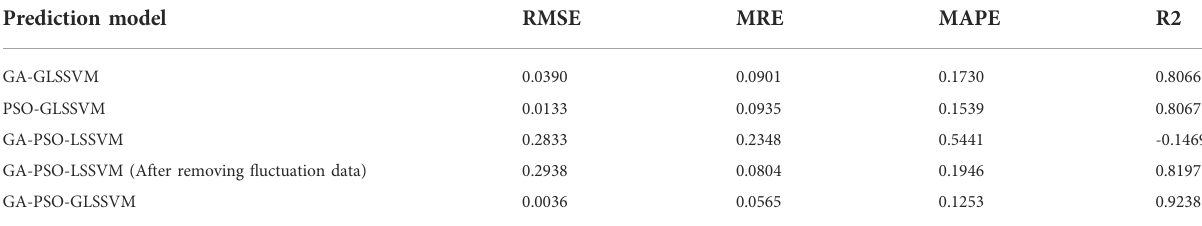
TABLE 4 Comparison of prediction accuracy of each model. Prediction